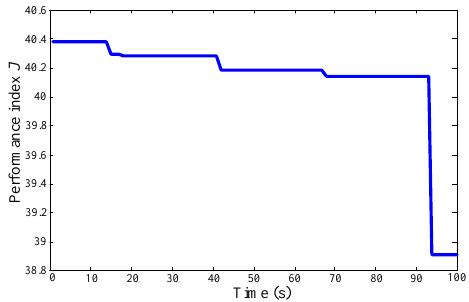
Figure 6. The optimal process of performance index J .